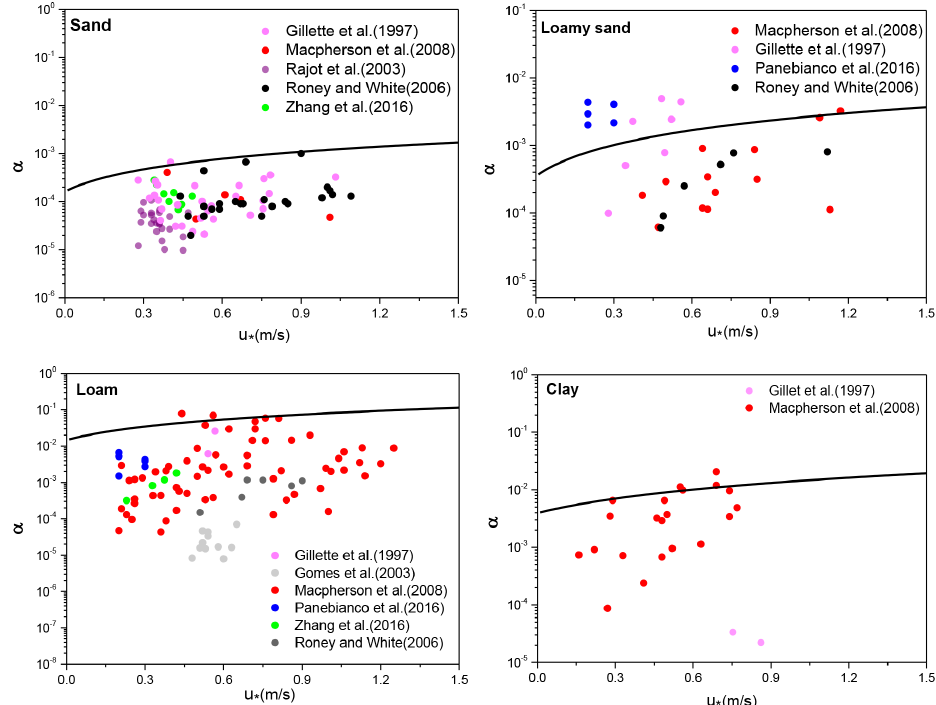
Figure 6. Updated sandblasting efficiency α as a function of surface friction velocity u ∗ following Lu and Shao (1999) for sand, loamy loam, loam and clay and observations from the